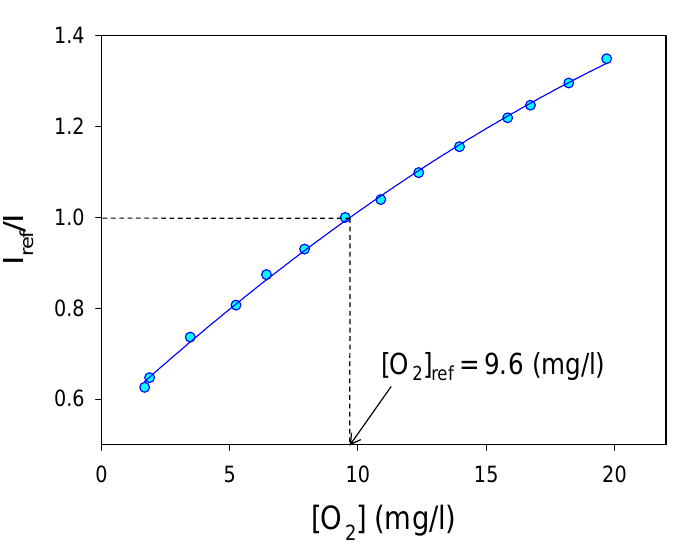
Figure 7. Oxygen calibration